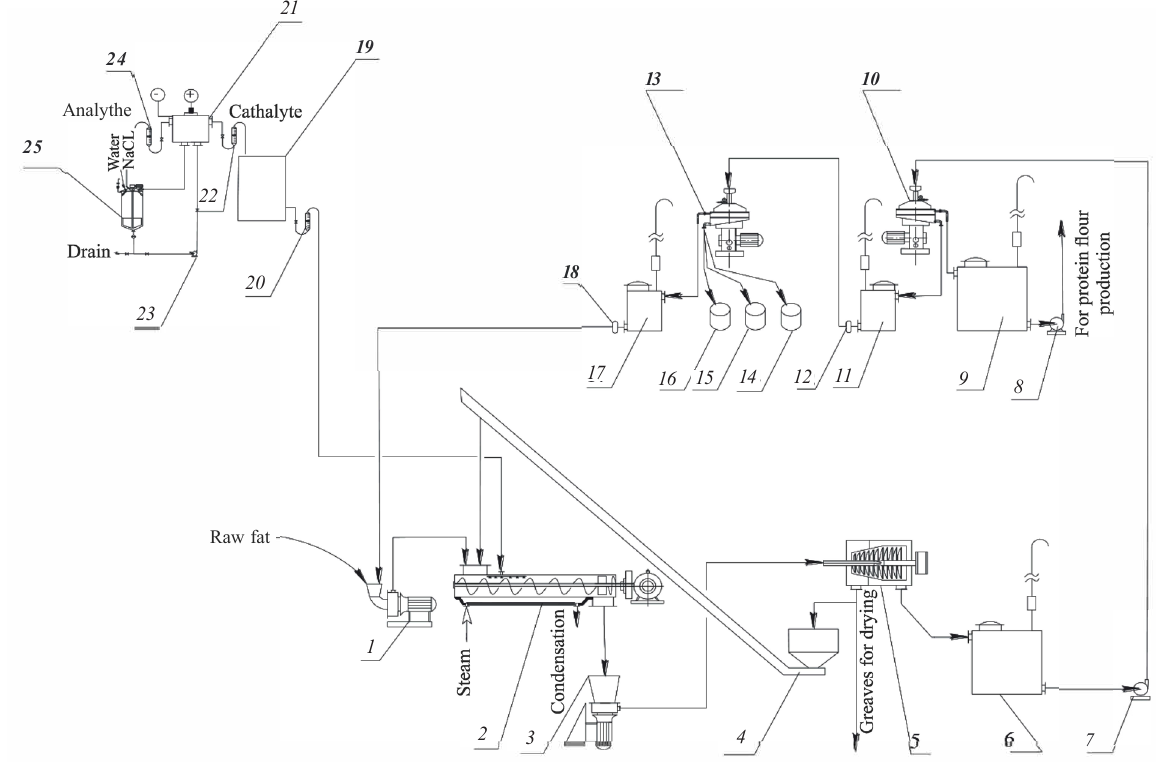
Figure 2 Ostrich fat production line [29]. 1 – device for primary grinding of raw fat; 2 – worm inactivator IN-20; 3 – disintegrator; 4 – hopper with a helix lift; 5 – pulp separation device; 6 , 17 – vertical free-flow tank for collecting fat-water fraction; 7 , 8 , 12 , 18 , 23 – pump; 9 – vertical free-flow tank for collecting water-protein fraction; 10 – the first separator of the fat-water fraction; 13 – the second separator; 14 , 15 , 16 – tanks for collecting fat fractions with a predetermined melting point; 19 – tank for electrochemically activated solution; 20 , 22 , 24 – flowrator; 21 – device for obtaining electrochemically activated solution (electrolyzer); 25 – tank for NaCL